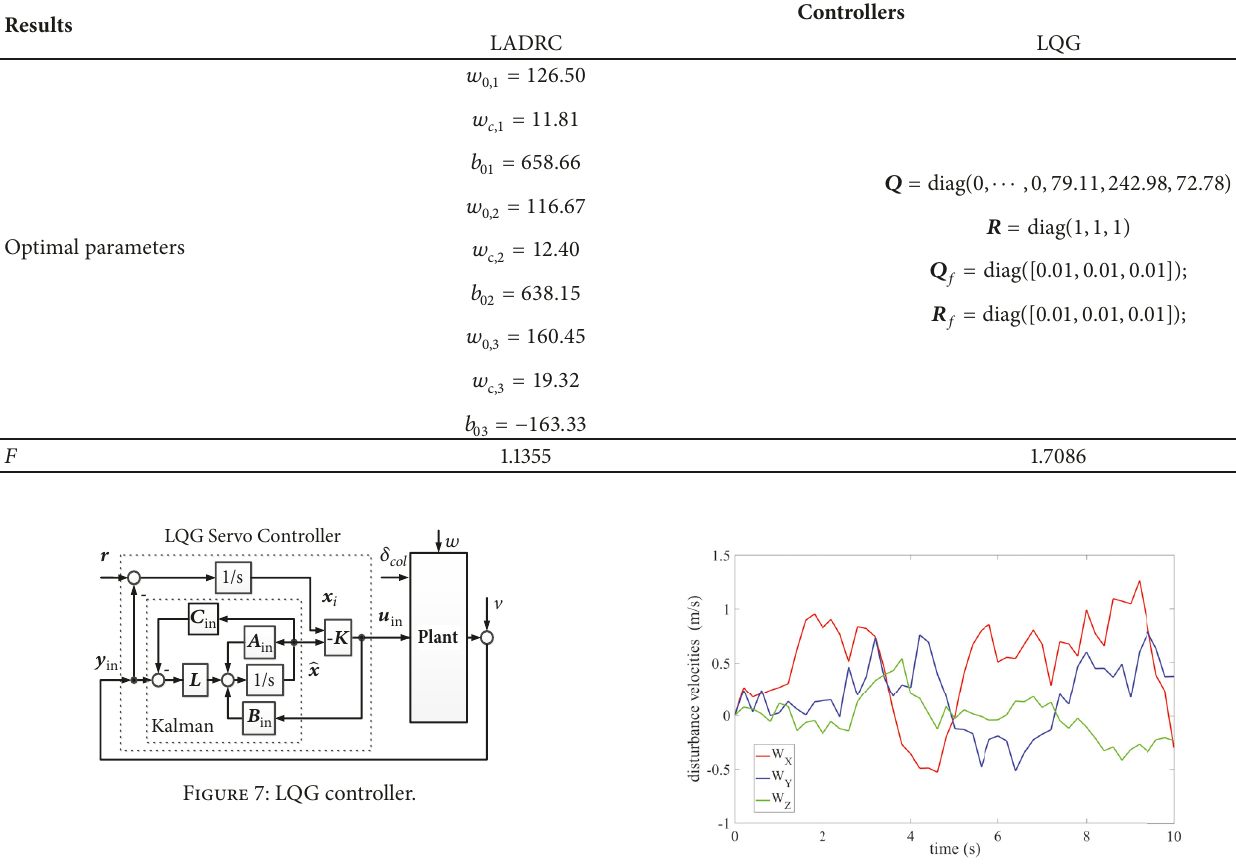
Figure 8: Wind disturbance